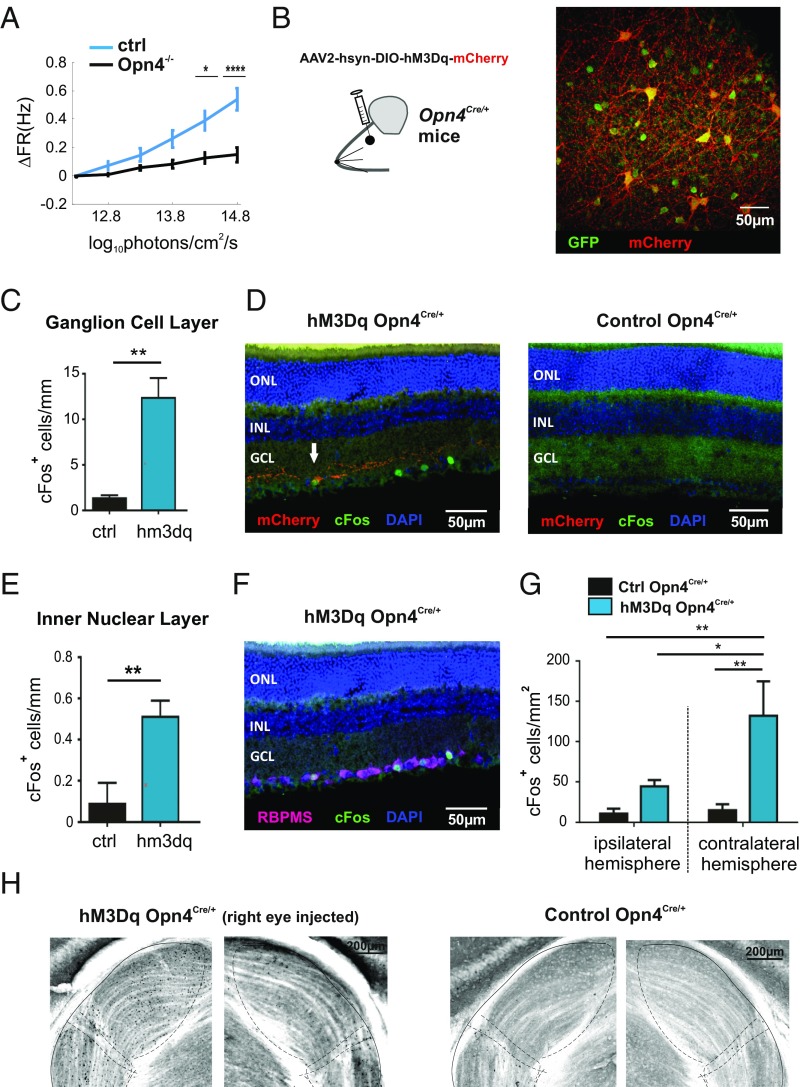
ipRGCs contribute to modulations in RGC-maintained activity. (A) Changes in firing rate induced by a gradual irradiance ramp (11–14.8 log photons⋅cm−2⋅s−1 over 13 min) were substantially deficient in Opn4−/− mice (black lines) compared with controls (blue lines). Statistically significant differences were determined after Bonferroni correction (P = 0.18, 0.25, 0.02, 0.004, and 3 × 10−9; zval = 1.33, 1,15, 2.28, 2.88, and 5.89, rank sum tests; n = 455 and 662, control and Opn4−/− mice, respectively). (B) Intravitreal injections of viral vector (AAV2-hsyn-DIO-hM3Dq-mCherry) in Opn4Cre/+;Z/EGFP mice (Inset) resulted in immunoreactivity for mCherry (red) in a subset of GFP-positive ipRGCs (green). Shown here for representative retinal whole mount. (Scale bar: 50 μm.) (C) Mean (±SEM) c-Fos–positive cells per millimeter length of retinal section after CNO administration (5 mg/kg, i.p.) was higher in hM3Dq-expressing (blue bar; n = 6) than control (black bar; n = 4) retinas in ganglion cell layer (GCL) and inner nuclear layer (INL). Unpaired t test; **P < 0.01. (D) Immunohistochemical staining of representative retinal sections showing c-Fos (green) expression in hM3Dq-expressing (Left) but not control (Right) retina held in dark but exposed to CNO extending beyond hM3Dq-expressing (mCherry immunoreactive, red) ipRGCs (arrow). (E) Same as C for INL. (F) Representative retinal section from a hM3Dq-expressing mouse following CNO administration stained for c-Fos (green) and RBPMS (purple) immunoreactivity showing all c-Fos–positive cells also positive for the ganglion cell marker RBPMS. Blue shows DAPI nuclear counterstain. (G) Mean (±SEM) c-Fos–positive cells per square millimeter in ipsilateral and contralateral dLGN after CNO administration (5 mg/kg, i.p.) in hM3Dq-expressing (blue bars; n = 6) and control (black bars; n = 6) mice (two-way ANOVA, *P < 0.05 and **P < 0.01). (H) Representative micrographs of coronal sections through lateral geniculate nucleus (approximate margins for dorsal and ventral subdivisions and intergeniculate leaflet shown with dotted lines) contralateral (Left) or ipsilateral (Right) to the eye injected with hM3Dq virus (Left) or vehicle control (Right) show c-Fos immunoreactivity (dark) in the former but not the latter following CNO administration. *P < 0.05, ***P < 0.0001.